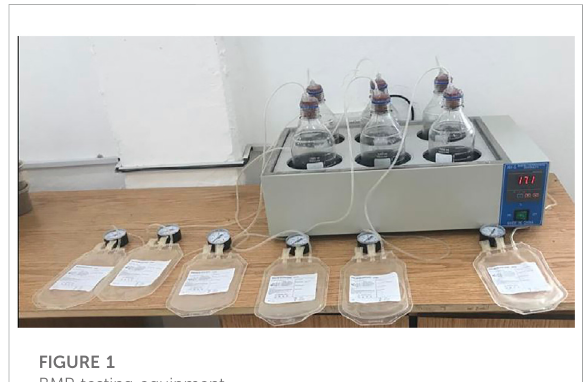
TABLE 2 Concentration of the IONPs utilized in the AD process